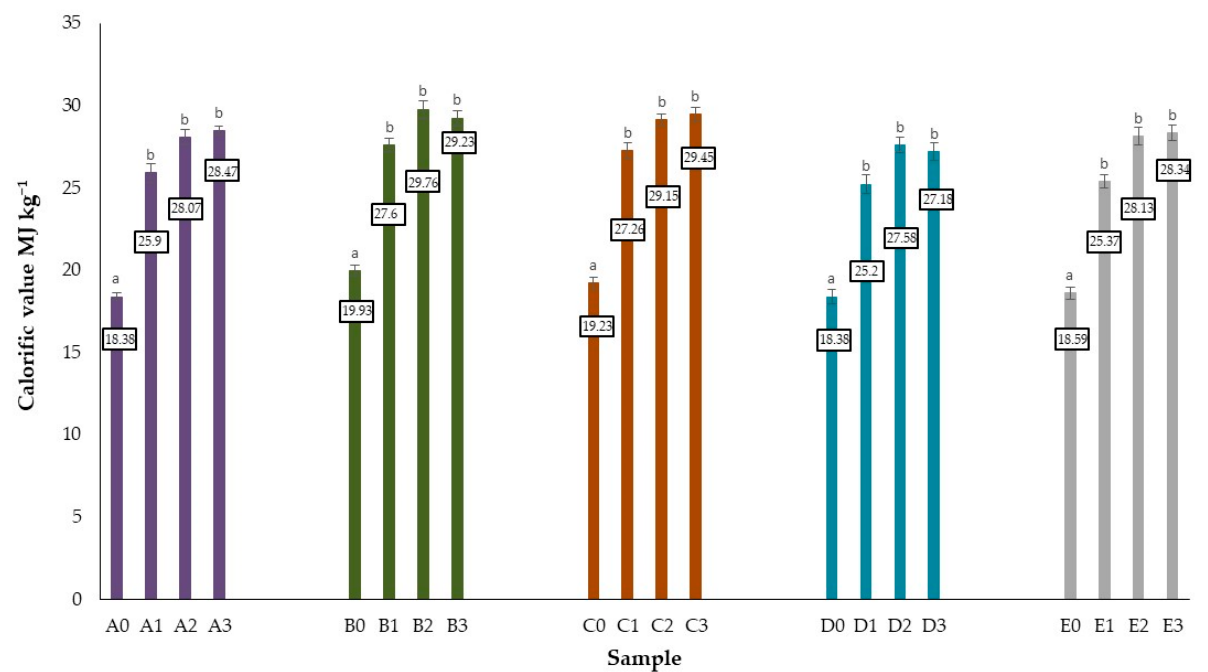
Figure 2. Calorific value of oak biomass and produced biochars. Differences between average values described with the same alphabet signs are statistically insignificant at the level of p ≤ 0.05 based on the Duncan test. The data were analyzed separately for each type of materials.